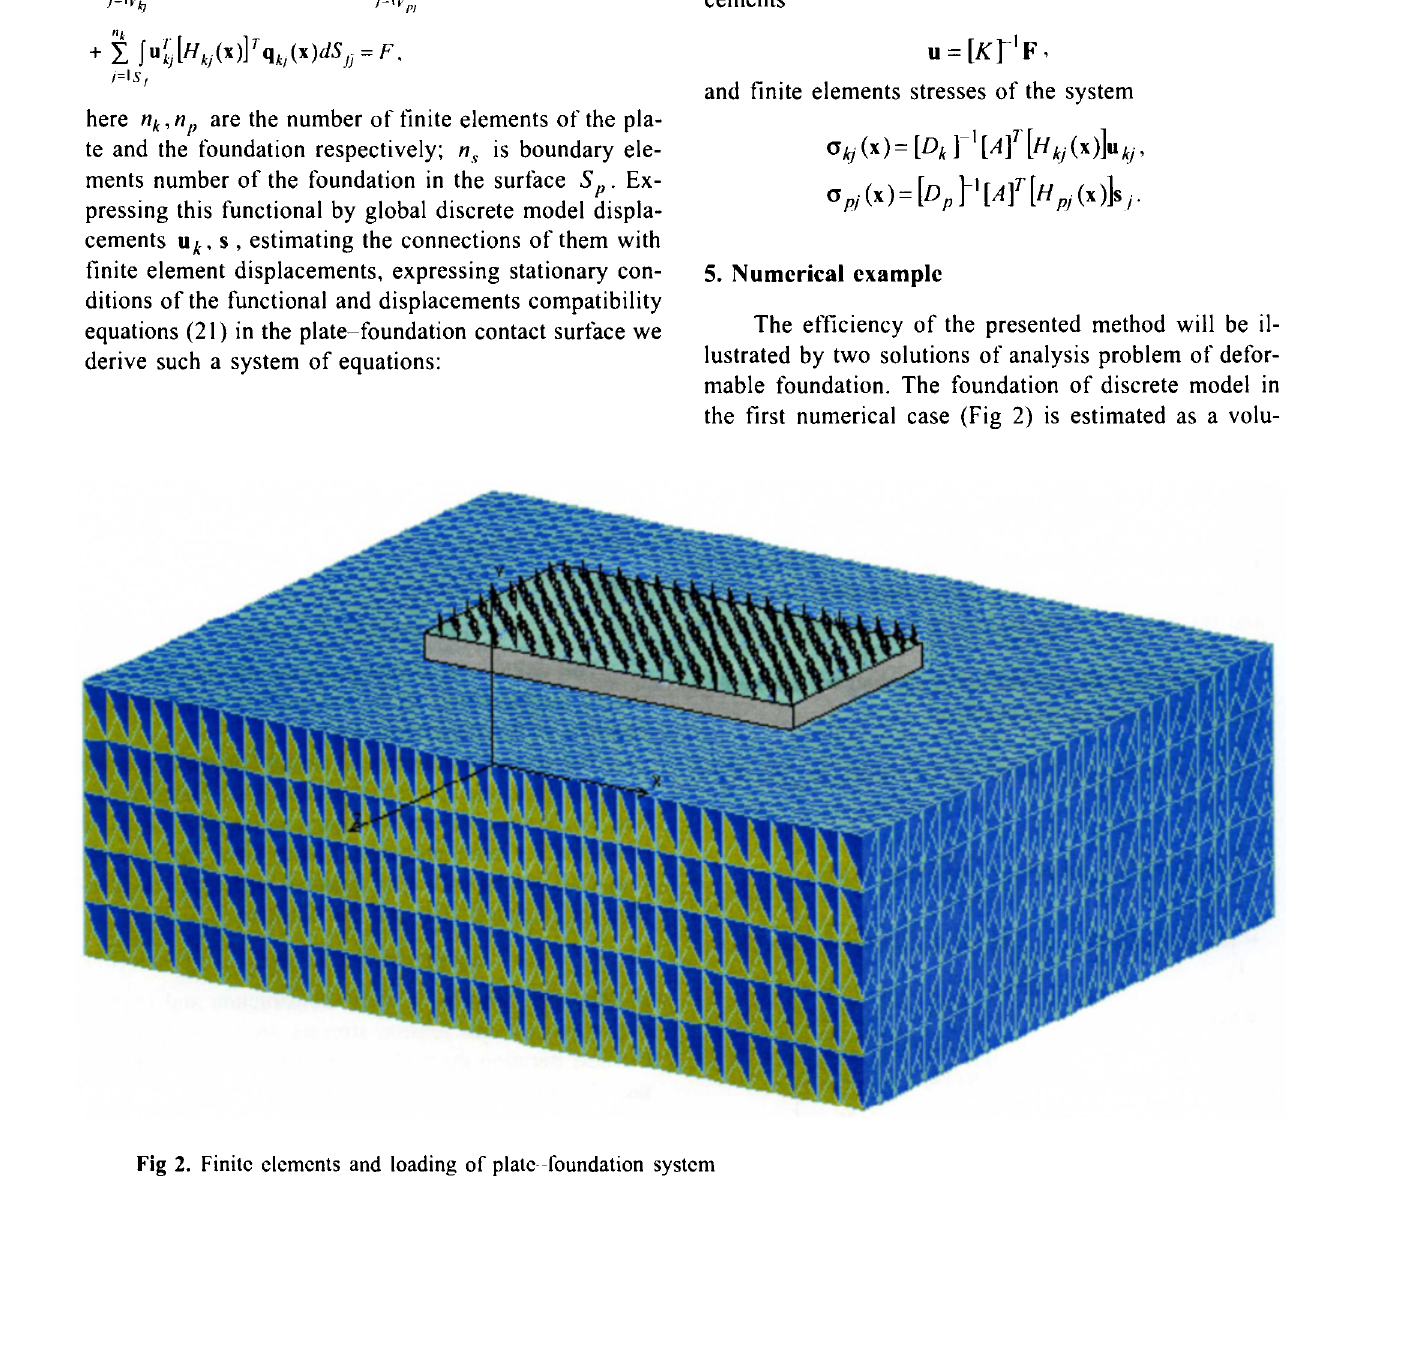
Fig 2. Finite clements and loading of plate--foundation